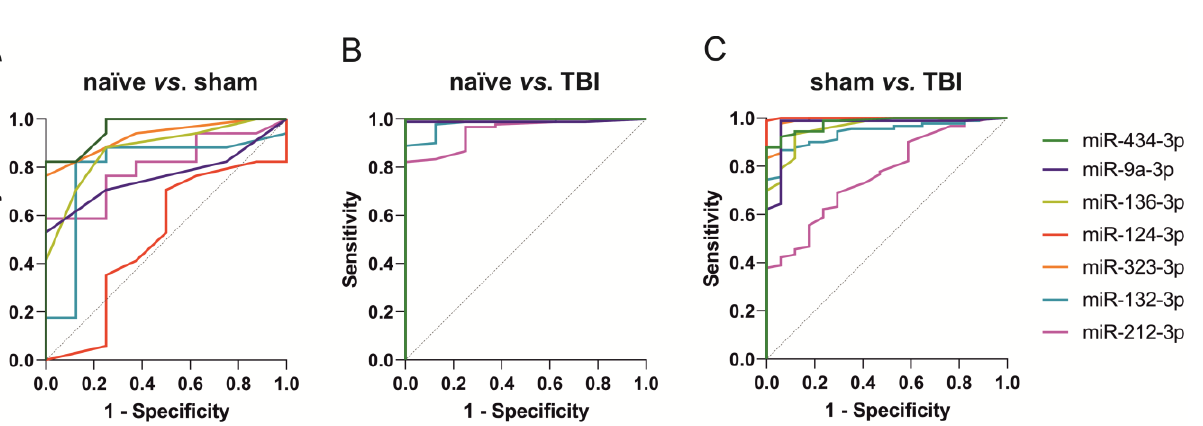
Figure 4. ROC analysis of plasma miRNA levels measured on D2 after TBI or sham operation. ( A ) Naïve vs. sham. Of 7 miRNAs, 6 (miR-434-3p, miR-9a-3p, miR-136-3p, miR-323-3p, miR-132-3p, and miR-212-3p) separated sham-operated controls ( n = 17) from naïve rats ( n = 8; p < 0.05). MiR-124-3p did not separate sham-operated controls from naïve animals (AUC 0.59, p > 0.05). See results for details. ( B ) TBI vs. naïve. All analyzed miRNAs separated rats with TBI ( n = 90) from naïve animals ( n = 8) with an AUC ≥0.90 ( p < 0.001), indicating a very good performance as diagnostic TBI biomarkers. ( C ) TBI vs. sham operation. All analyzed miRNAs separated rats with TBI ( n = 90) from sham-operated controls ( n = 17). MiR-434-3p, miR-9a-3p, miR-136-3p, miR-323-3p, and miR-132-3p had AUC ≥0.90 ( p < 0.001), whereas miR-212-3p had an AUC of 0.76 ( p < 0.001). See results for details. Abbreviations: TBI, traumatic brain injury.